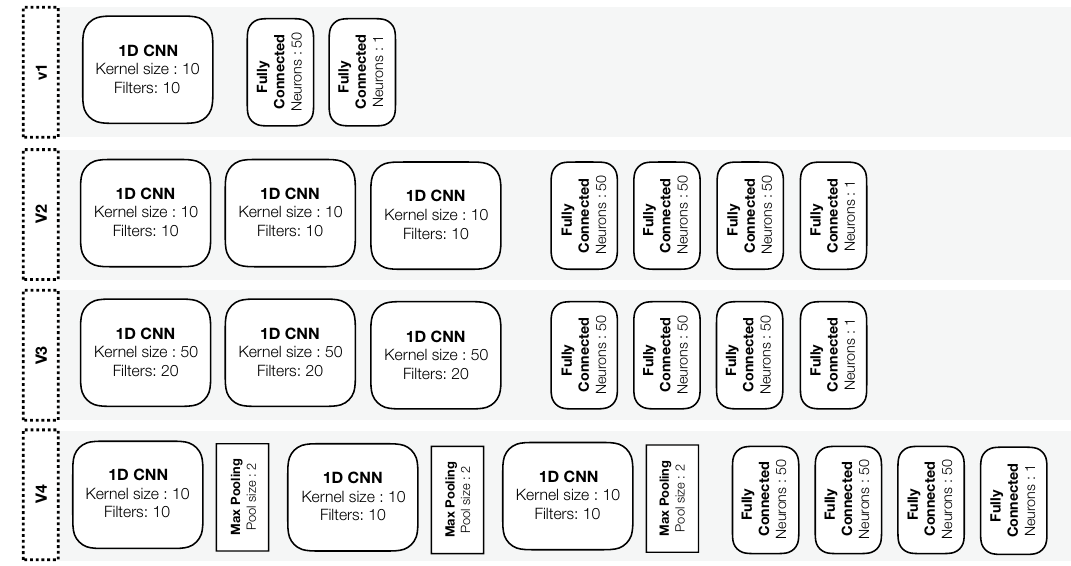
Figure 2. Overview of the four convolutional neural network architectures used for binary classification of start and stop features extracted from wear and non-wear episodes. Before the first fully connected layer, the output data from the previous layer is